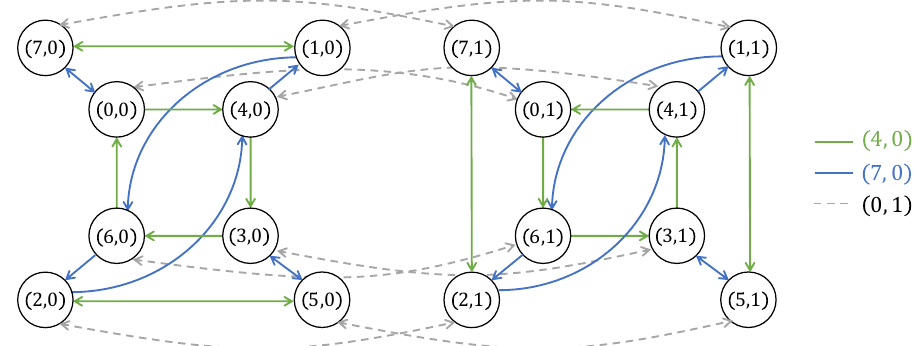
Figure 4. The right Cayley graph C 2 = RCay ( Dih ( G 8 ) , (cid:101) S 2 ) , where S 2 = { 4,7 } , in Example